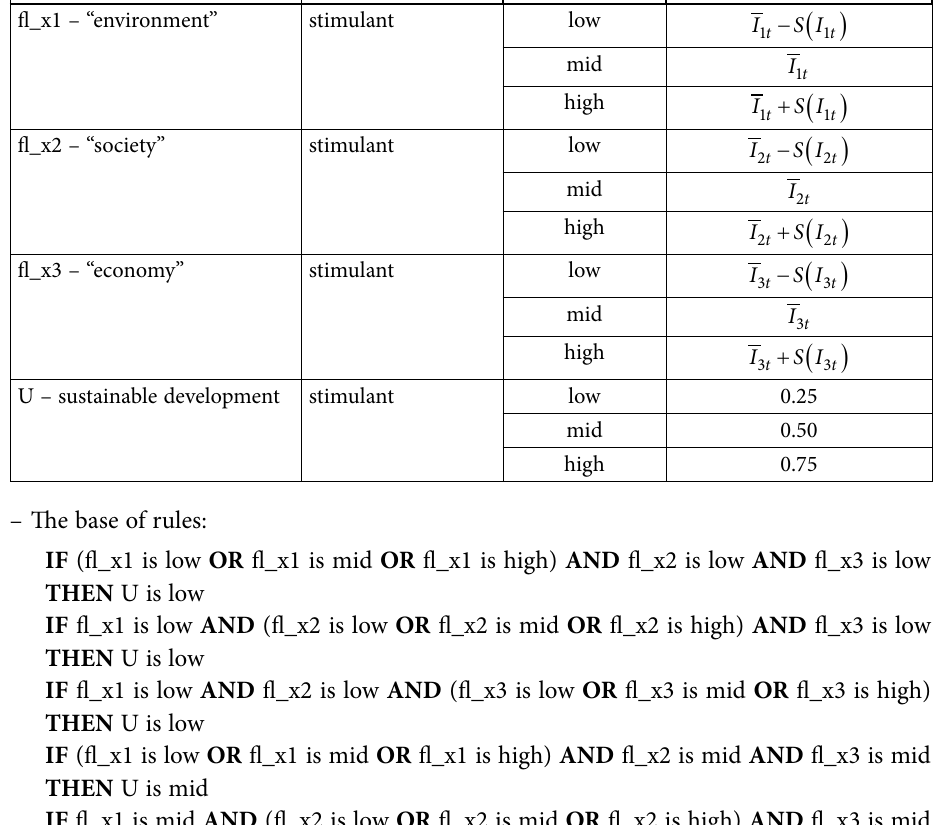
Table 1. Linguistic input variables Linguistic